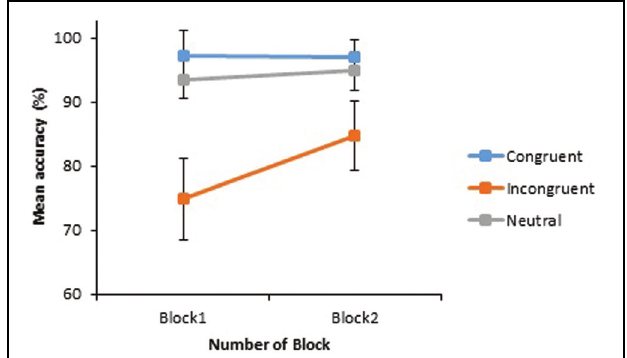
FIGURE 1 | Experiment 1: mean percentages of correct judgments to critical word pairs in Block 1 and Block 2. The vertical axis begins at 60% while error bars indicate the 95% confidence